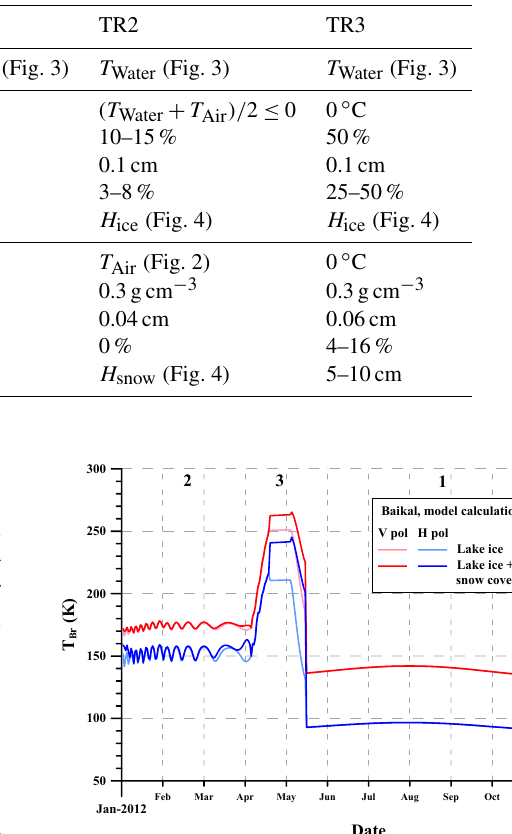
Figure 9. Model variations of brightness temperature within the SMOS L1C grid cell for Baikal. TR2 and TR3 are calculated for ice without snow (rose and blue lines) and covered by snow (red and blue